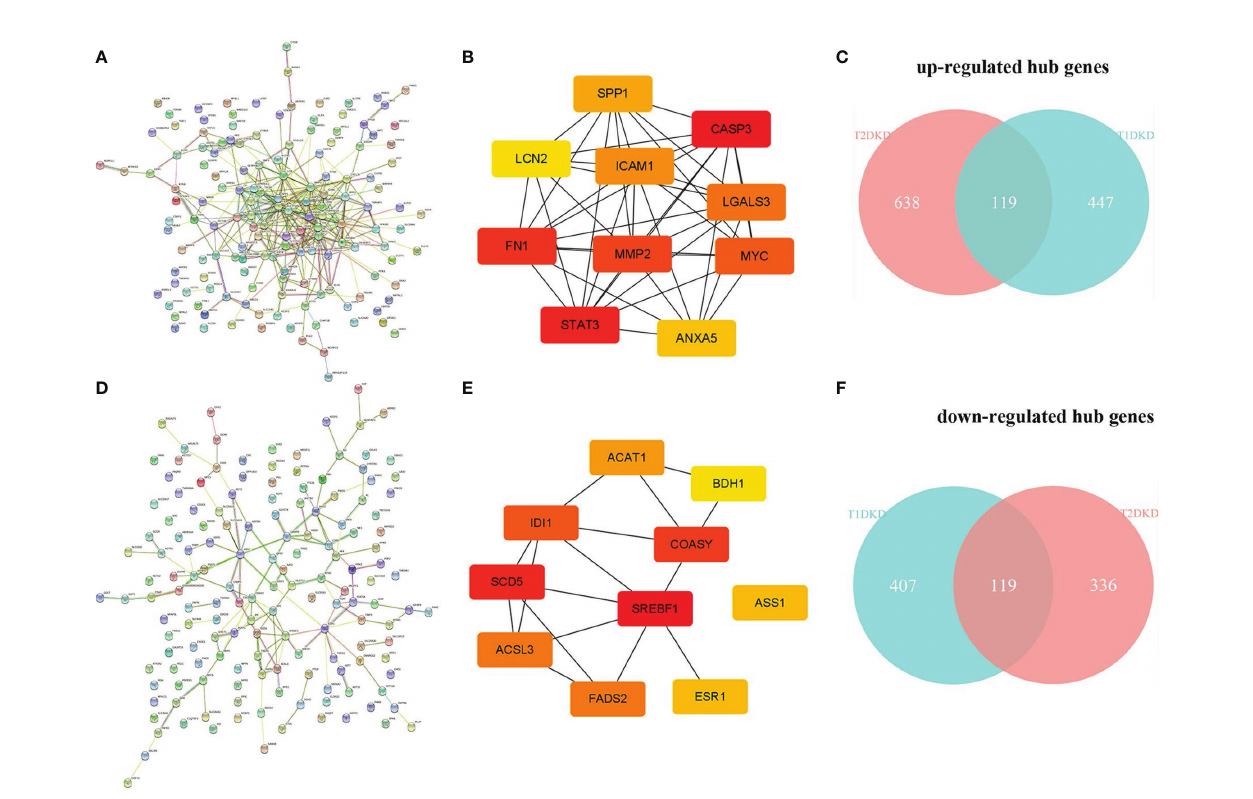
FIGURE 4 | Protein-protein interaction (PPI) network construction and hub gene screening: (A) The PPI network constructed with the shared up-regulated DEGs. (B) Top 10 up-regulated hub genes. (C) Venn diagram of the shared up-regulated hub genes. (D) The PPI network constructed with the shared down-regulated DEGs. (E) Top 10 down-regulated hub genes. (F) Venn diagram of the shared down-regulated hub genes.